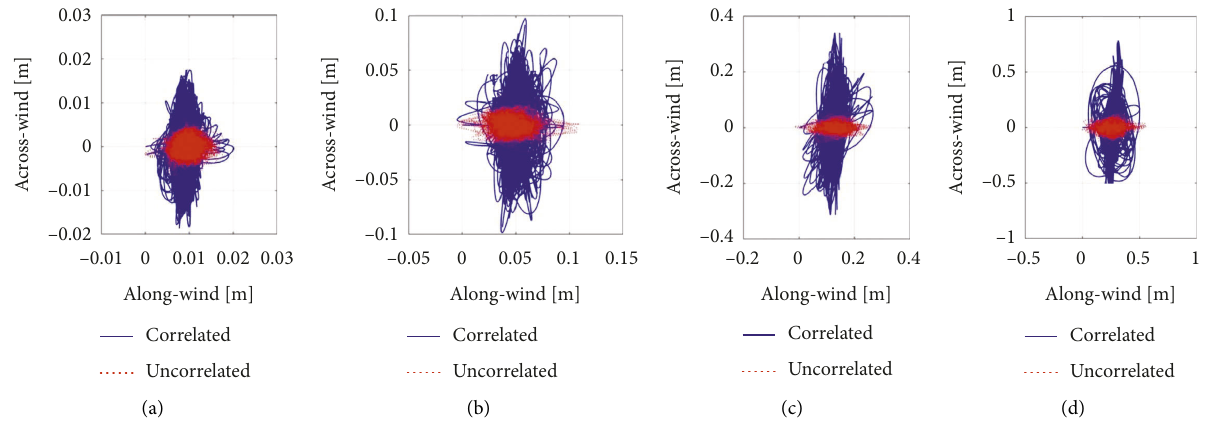
Figure 21: Rooftop displacements of the shear buildings in time domain. (a) H/ √ BD � 2, (b) H/ √ BD � 4. (c) H/ √ BD � 6. (d) H/ √ BD �